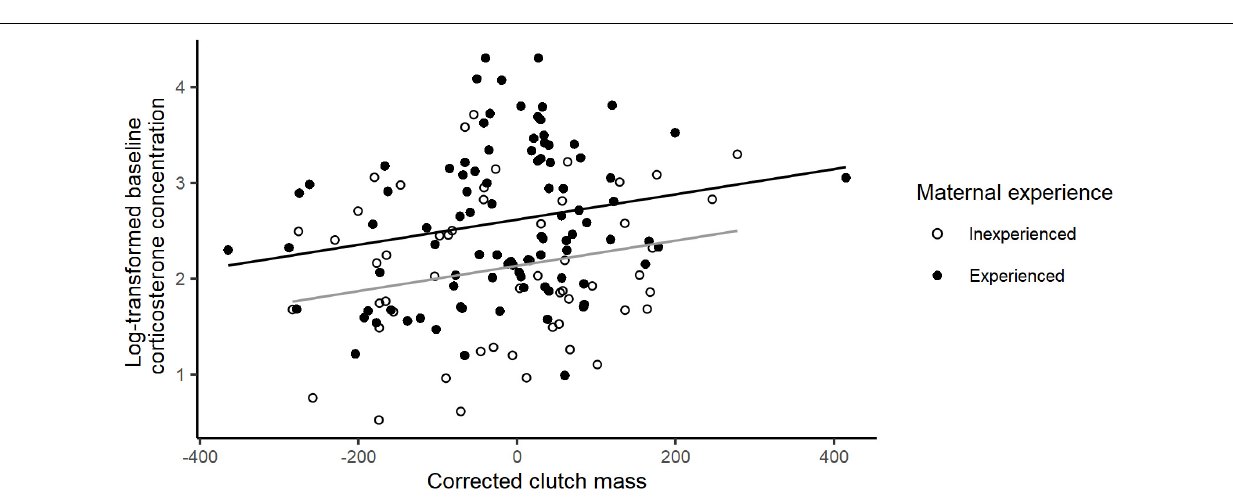
FIGURE 2 | Relationship between baseline log-transformed baseline corticosterone levels and incubation-stage corrected clutch weight of incubating female eiders for experienced (in black) and inexperienced (in gray)